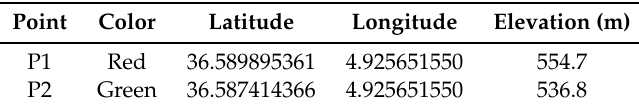
Figure 7. Heavy rainfalls context: a physical simulation produced positions with the risk of flash flooding (dark blue color). The communication coverage of a base station with a star network is predicted for sensor nodes monitoring level of water in these positions. An algorithm selects reachable sensor positions from a network sink, sorts, then extracts 15 positions according to the flooding result simulation. More details about accuracy are given in Section 3. Table 1. Geo-locations of points where values of water level were